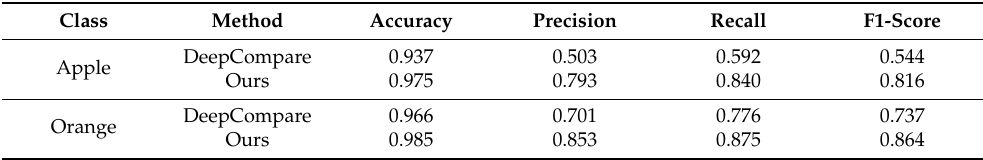
Table 4. Quantified evaluation results of the fruit matching